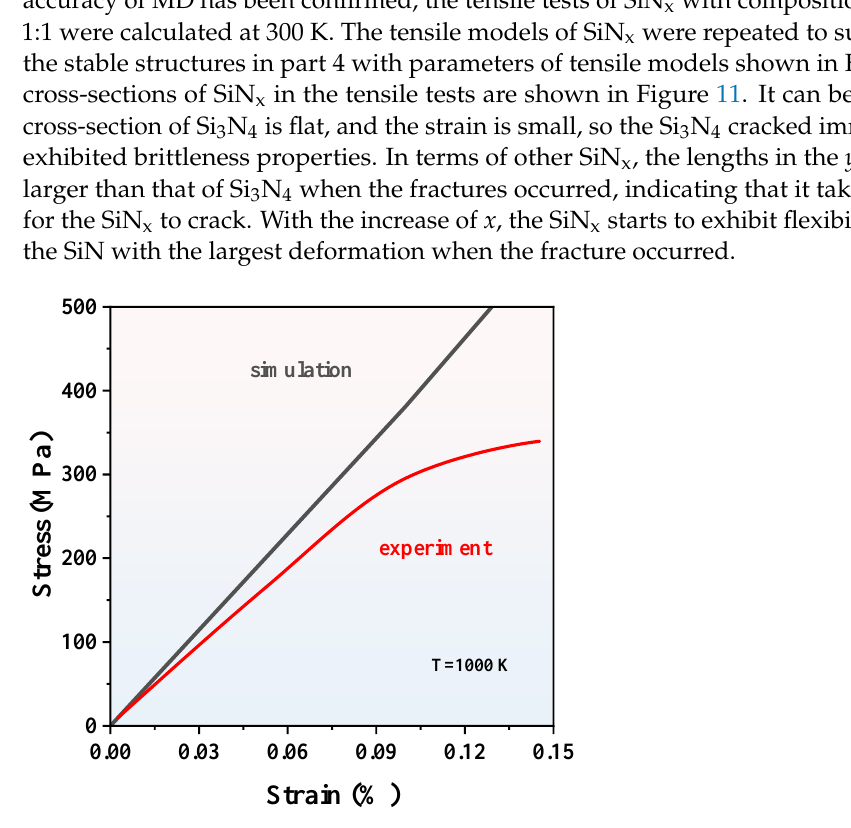
Figure 10. The simulated and experimental [39] strain–stress comparison of Si 3 N 4 . Reproduced with permission [39]. Copyright 2018 Elsevier.